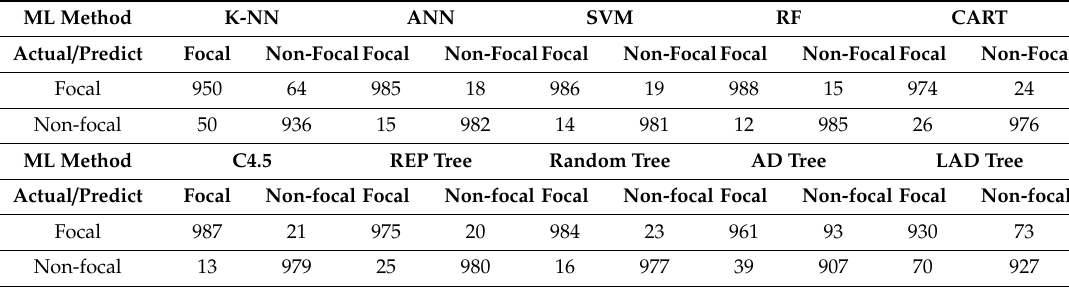
Table A4. Confusion matrix for Random Subspace.